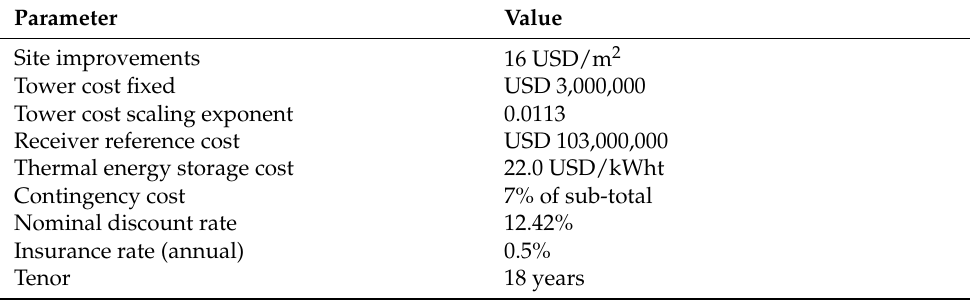
Table 2. Financial parameters used for the analysis